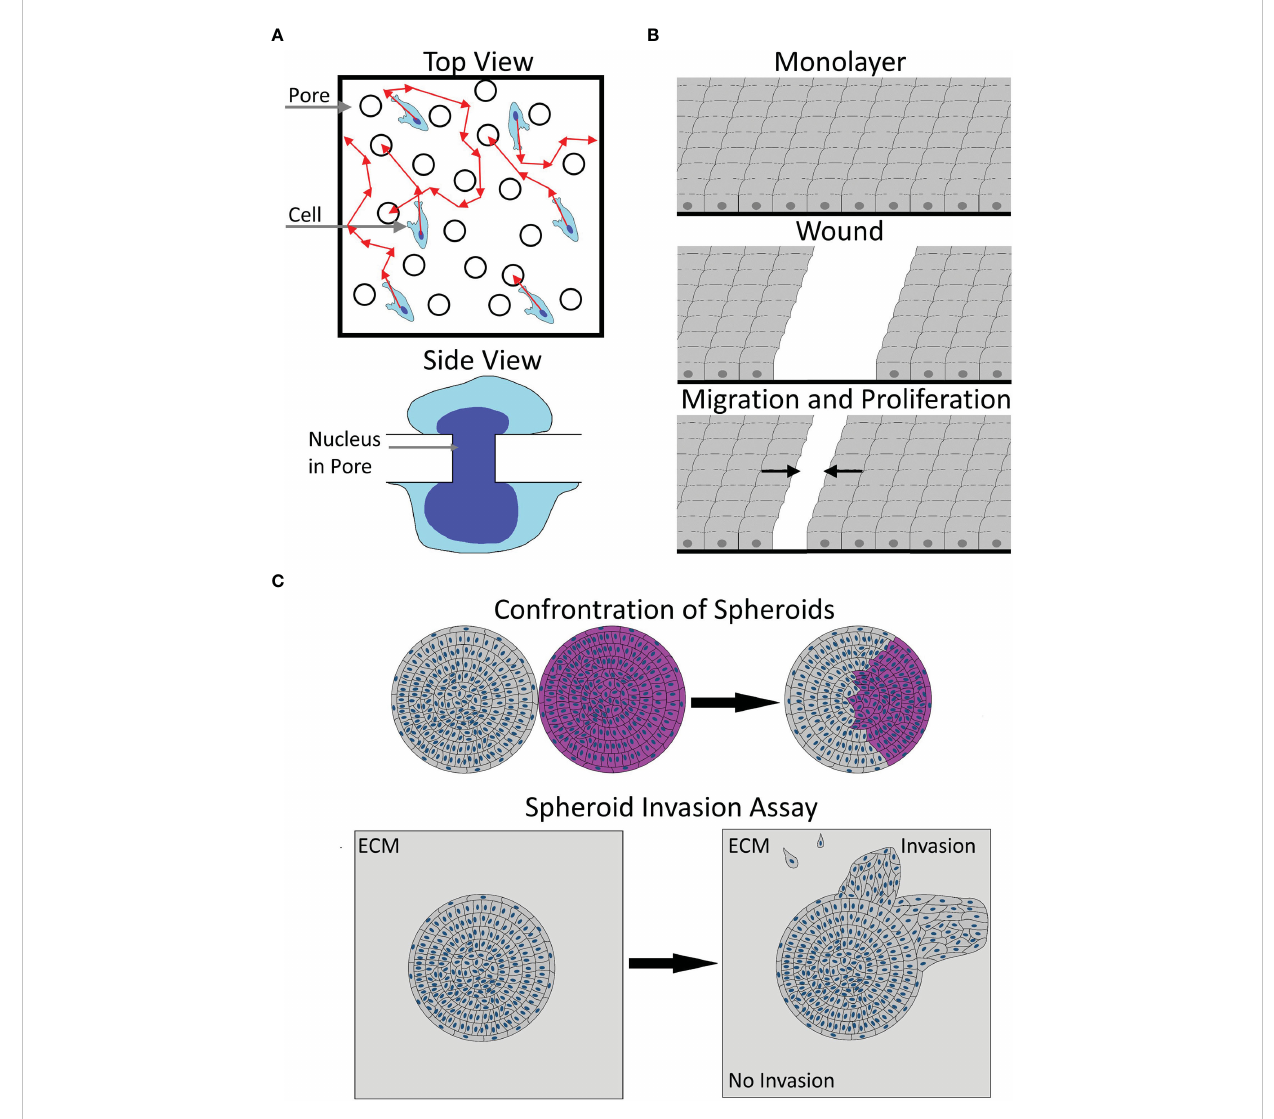
FIGURE 1 Illustration of migration models. (A) A sketch of the transwell model from the top (top) or side view (bottom). Please note the uneven distribution of pores and unclear cell path (red arrows) before contacting a pore in the top view. The side view shows the necessary, potentially rate-limiting deformation of the nucleus to pass a pore. (B) The working principle of a scratch wound assay, starting from an unscratched monolayer, via wounding, to subsequent wound closure by proliferation and migration. Arrows denote the average direction of migration. (C) Two types of 3D migration models. The top image shows a typical spheroid confrontation assay, bringing the spheroids of two cell populations (gray and pink) into contact, with the subsequent fusion of spheroids and intraspheroidal migration. The bottom image illustrates a typical spheroid invasion assay, showing an embedded spheroid, showing collective and single-cell invasion into the ECM. Arrows illustrate the transition from the start to the end of the